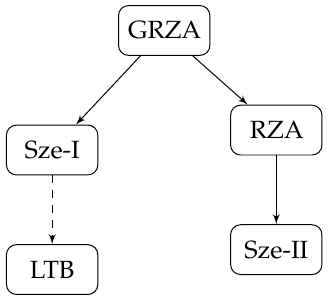
Figure 2. Special subcases of GRZA. GRZA contains class I of the Szekeres (Sze-I) solutions and all its subcases, such as the LTB models. In addition, RZA and the class II of Szekeres (Sze-II) emerge in the limit when ˆ k ( r ) → k 0 = const. and ˆ (cid:36) ( r ) → (cid:36) b ( t i ) =